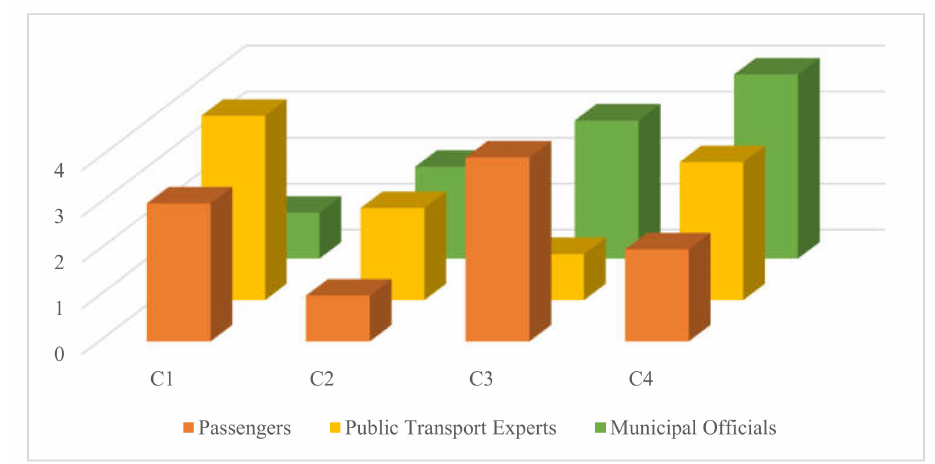
Figure 3. The main factors ranks based on the di ff erent group preferences in the first level.